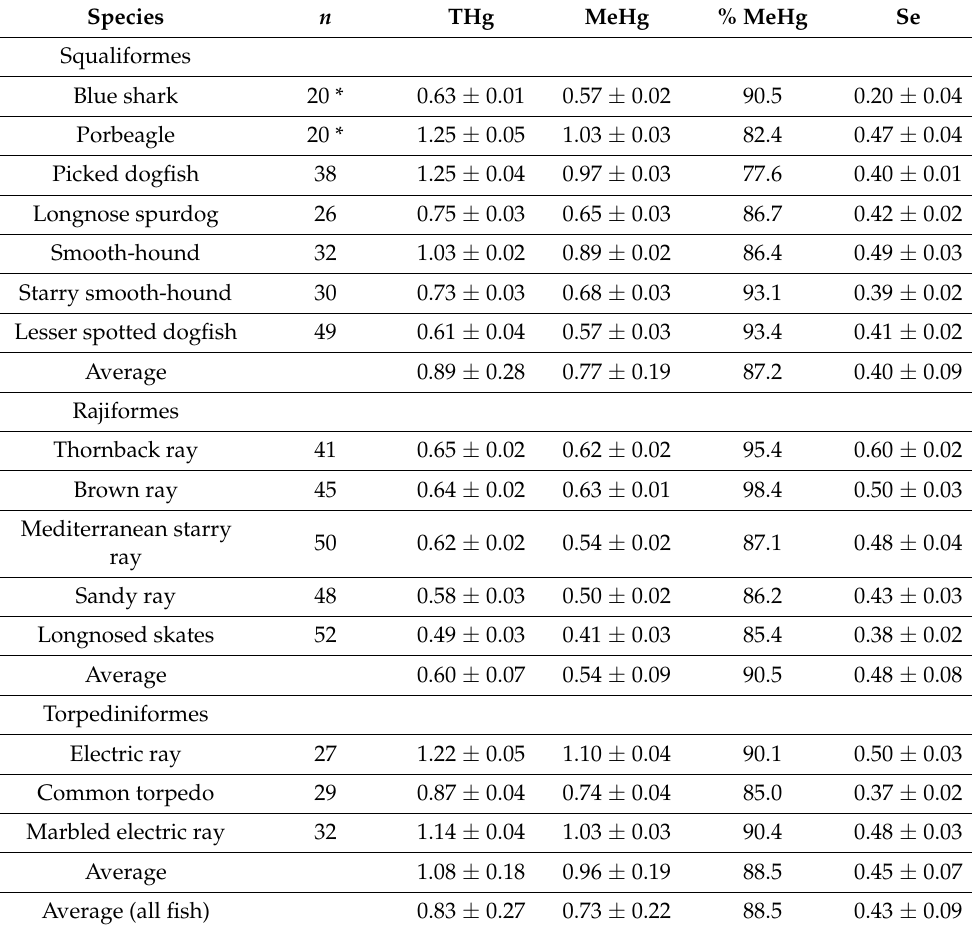
Table 1. Total mercury (THg), methylmercury (MeHg), selenium (Se) concentrations expressed in µ g g − 1 wet weight (means ± SD), percentages of methylmercury respect to THg and number of specimens ( n